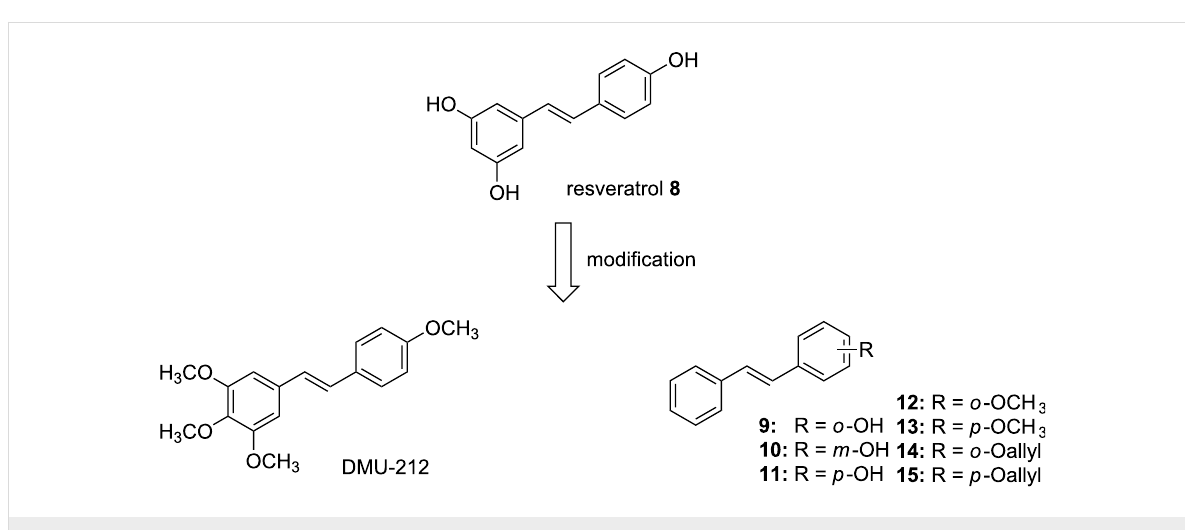
Figure 4: Structure of resveratrol and its